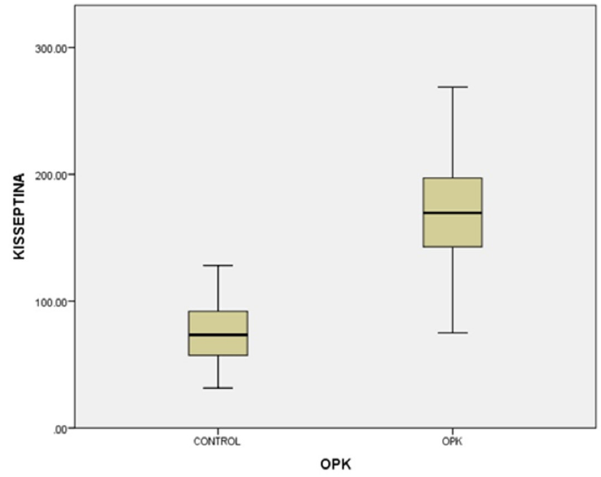
Figure 1. Univariate analysis of the relationship between kisspeptin serum levels and PCOS ( p < 0.001).